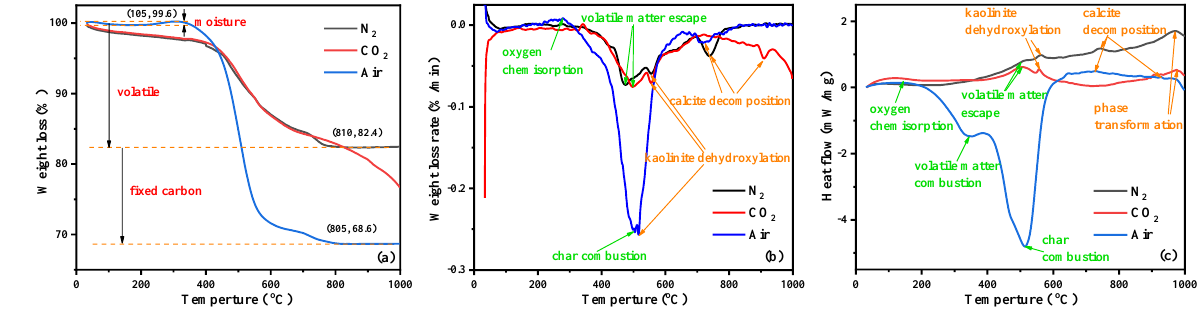
Figure 4. TGA ( a ), DTG ( b ), and DSC ( c ) curves of the KAS.